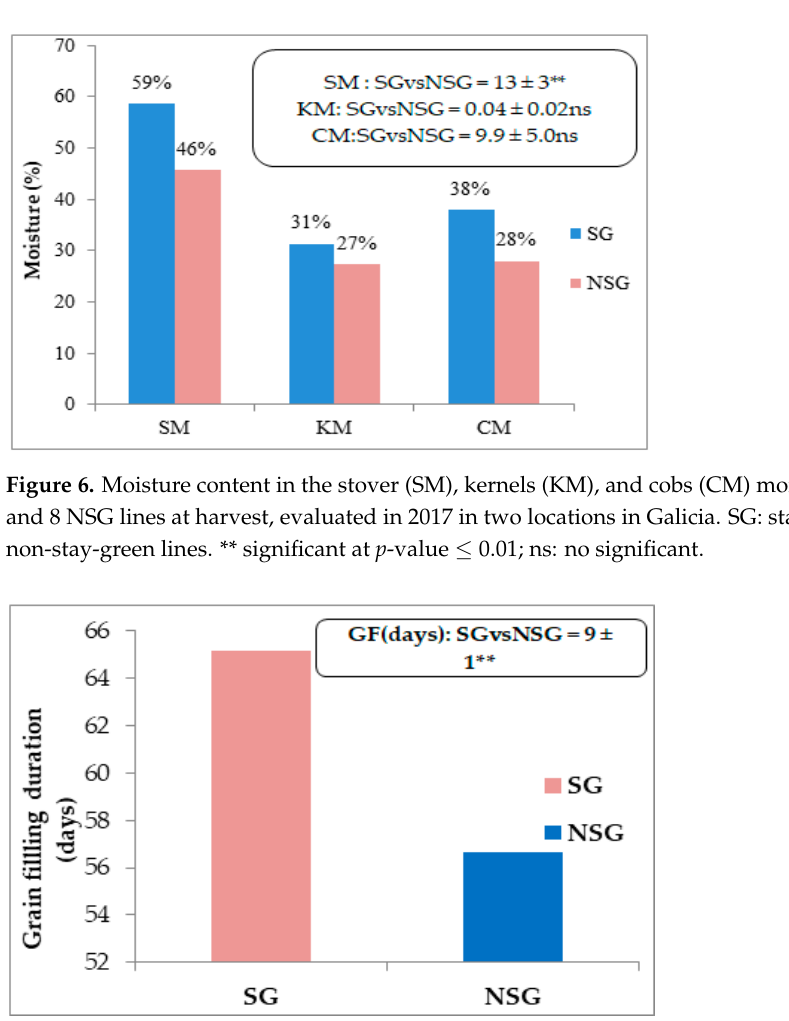
Figure 7. Duration of grain filling (days from flowering to black layer) of SG and NSG genotypes, evaluated in 2017 in two locations in Galicia. SG: stay-green lines. NSG: non-stay-green lines. ** significant at p -value ≤ 0.01.